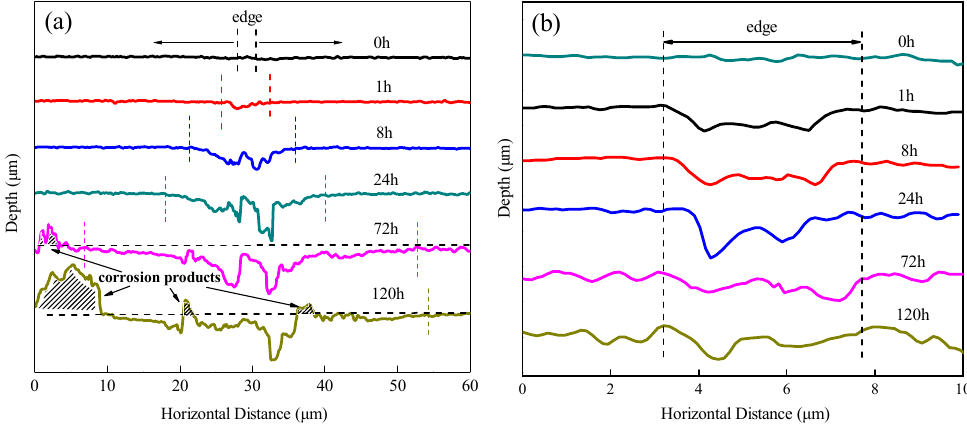
Figure 8. Cross section width and depth change where the AlFeSi phase is located (Figure 7a-I) and the position where the Mg 2 Si phase is located (Figure 7a-II): ( a ) AlFeSi phase, and ( b ) Mg 2 Si phase.